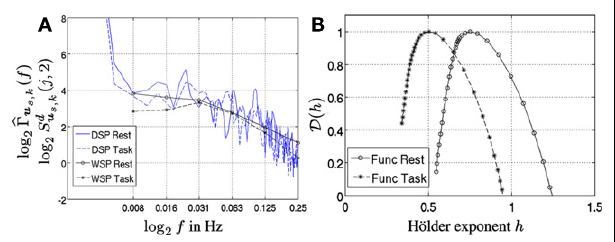
FIGURE 2 | (A) Welch (blue curves) vs.Wavelet ( black curves) spectra associated with a F-map ( f 18 ). Solid and dashed lines correspond to rest and task, respectively. (B) Corresponding multifractal spectra D ( h